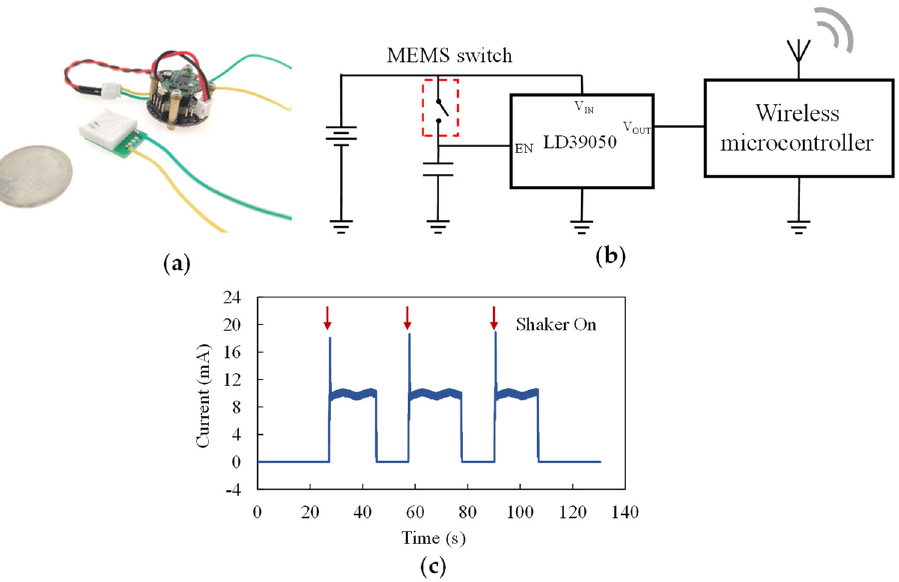
Figure 16. ( a ) A picture of the resonant acceleration switch connected with a sensor node; ( b ) circuit schematic of the sensor node; ( c ) test result of the sensor node’s power supply current.